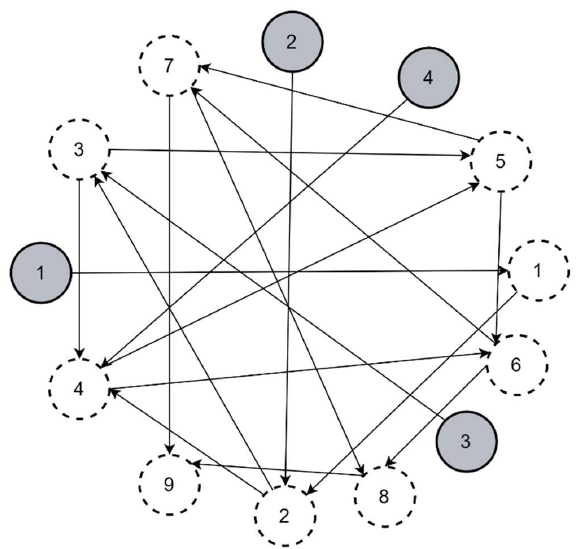
Figure 9. Goods distribution network N2. Appl. Sci. 2020 , 10 , x FOR PEER REVIEW